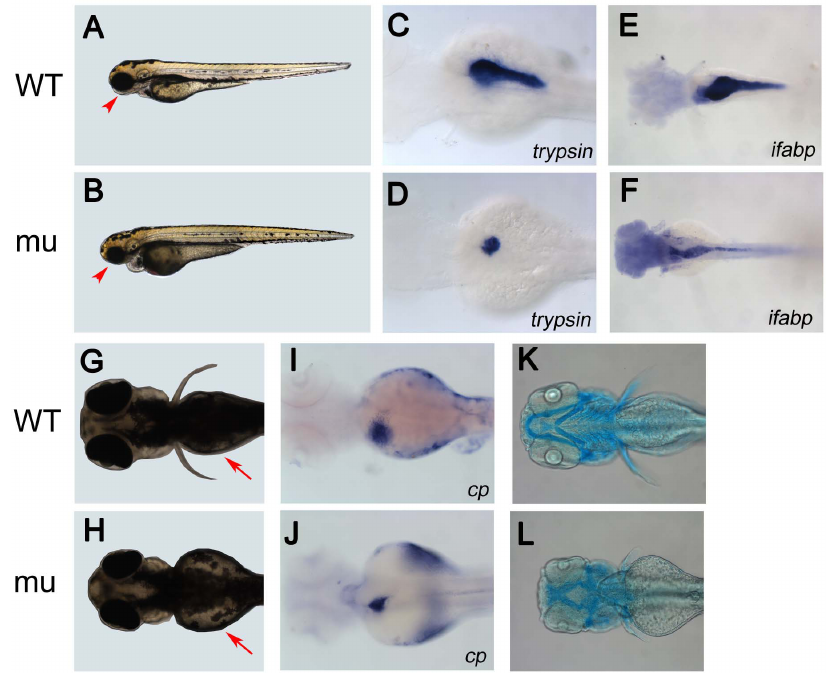
Figure 1. dg5 mutant has an endodermal and craniofacial defect. (A, B) Lateral and (G, H) dorsal views of live Wild Type (WT) sibling and dg5 larvae at 3 dpf. Smaller head and eyes can be seen (arrowhead in A, B). Impaired yolk absorption is apparent in dg5 mutant at 3 dpf (arrows in G, H). (C–F, I–L) All dorsal views, anterior to the left. At 3 dpf, the expression of trypsin (try) is markedly reduced in dg5 mutant (D) as compared to WT group (C). The intestine marker fatty acid binding protein 2 ( ifabp ) expression reveals that the intestine is thinner in dg5 larvae (E) as compared to WT group (F) at 3.5 dpf. The expression of ceruloplasmin ( cp) shows that the liver is smaller in dg5 mutant (H) as compared to WT group (I) at 3 dpf. As compared to control group (K), craniofacial development is abnormal in dg5 larvae (L) by alcian blue staining at 4